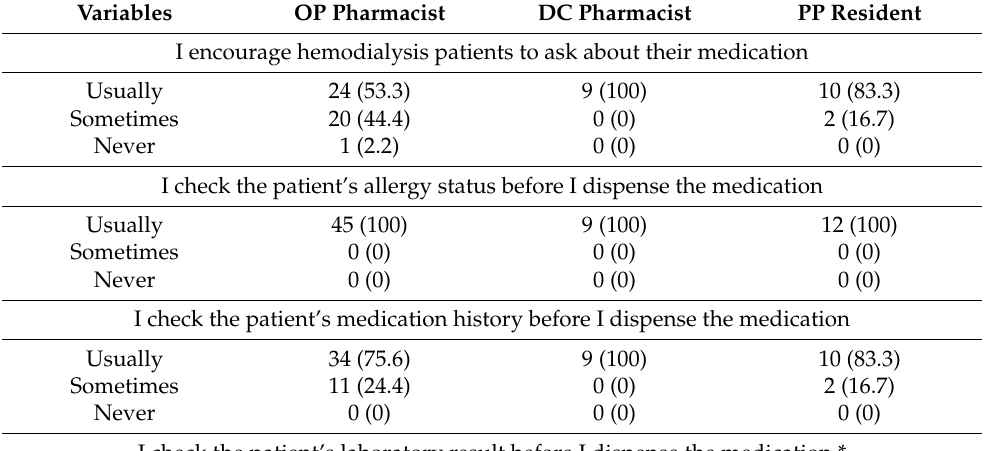
Table 3. Practices of the pharmacist before dispensing medications to hemodialysis patients. Variables OP Pharmacist DC Pharmacist PP